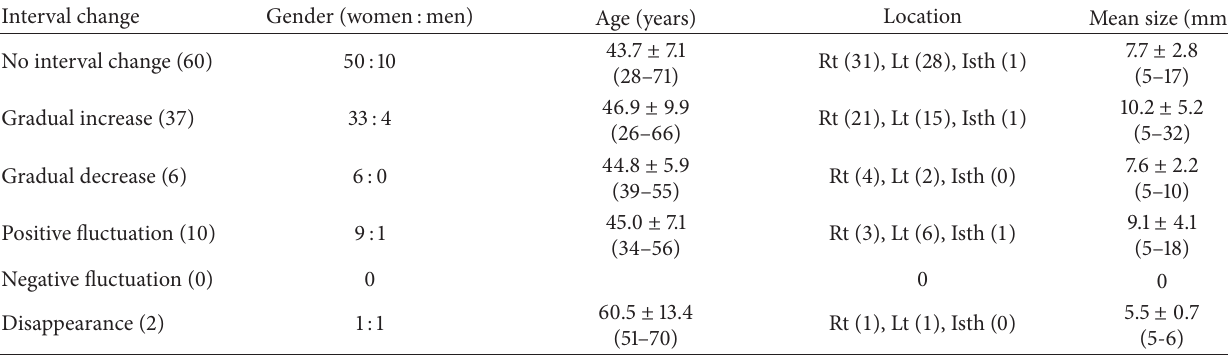
Table 1: The sonographic follow-up results of 115 subjects with thyroid colloid